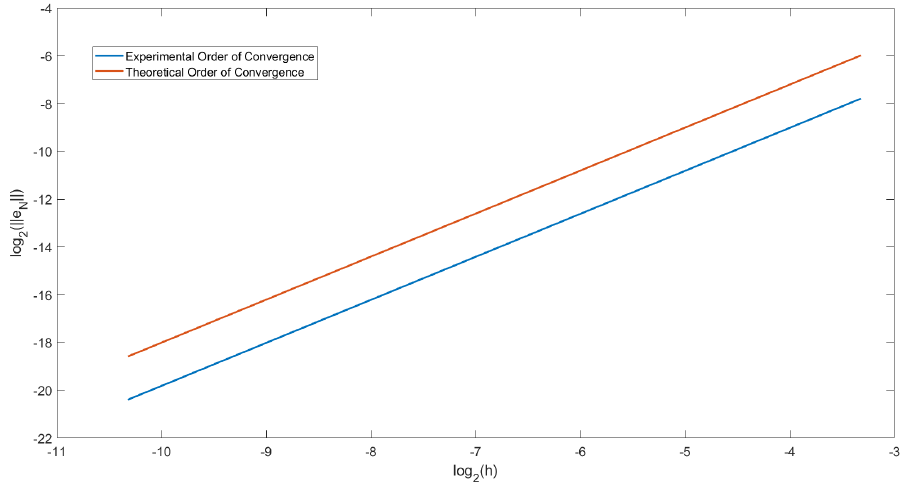
Figure 2. Graph showing the experimental order of convergence (EOC) at T = 2 in Example 2 with α = 0.8 and r = 1 + α β